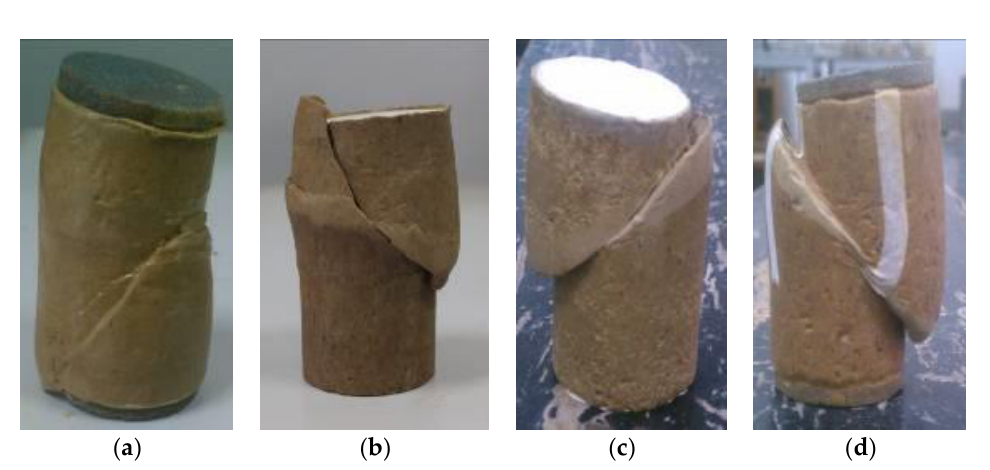
Table 2. Basic physical properties of the soils in the sample.